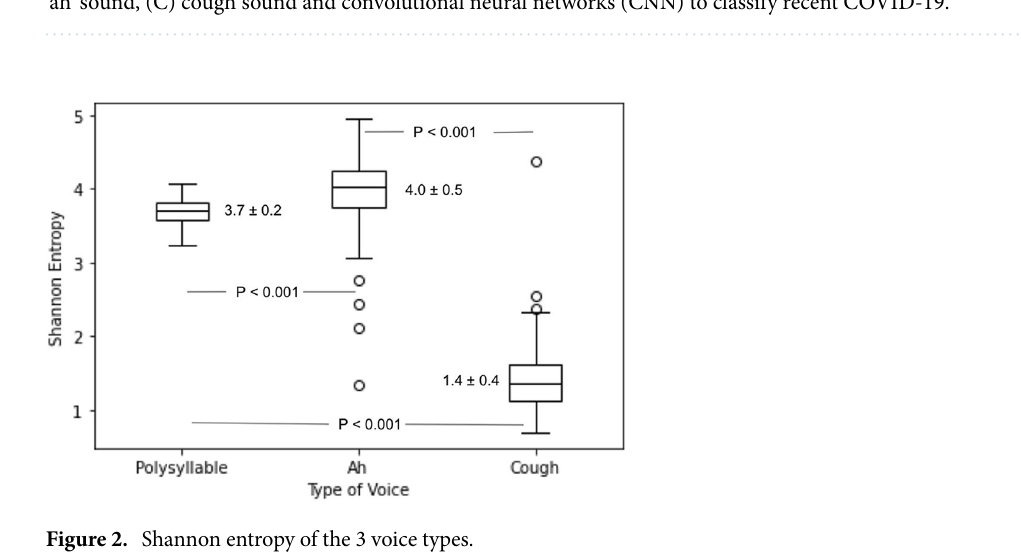
Table 3. The diagnostic performance of the (A) polysyllabic sentence ‘Hing-Hoy-Hor-Bin-Ha-Dao-Hang’, (B) ‘ah’ sound, (C) cough sound and convolutional neural networks (CNN) to classify recent COVID-19.